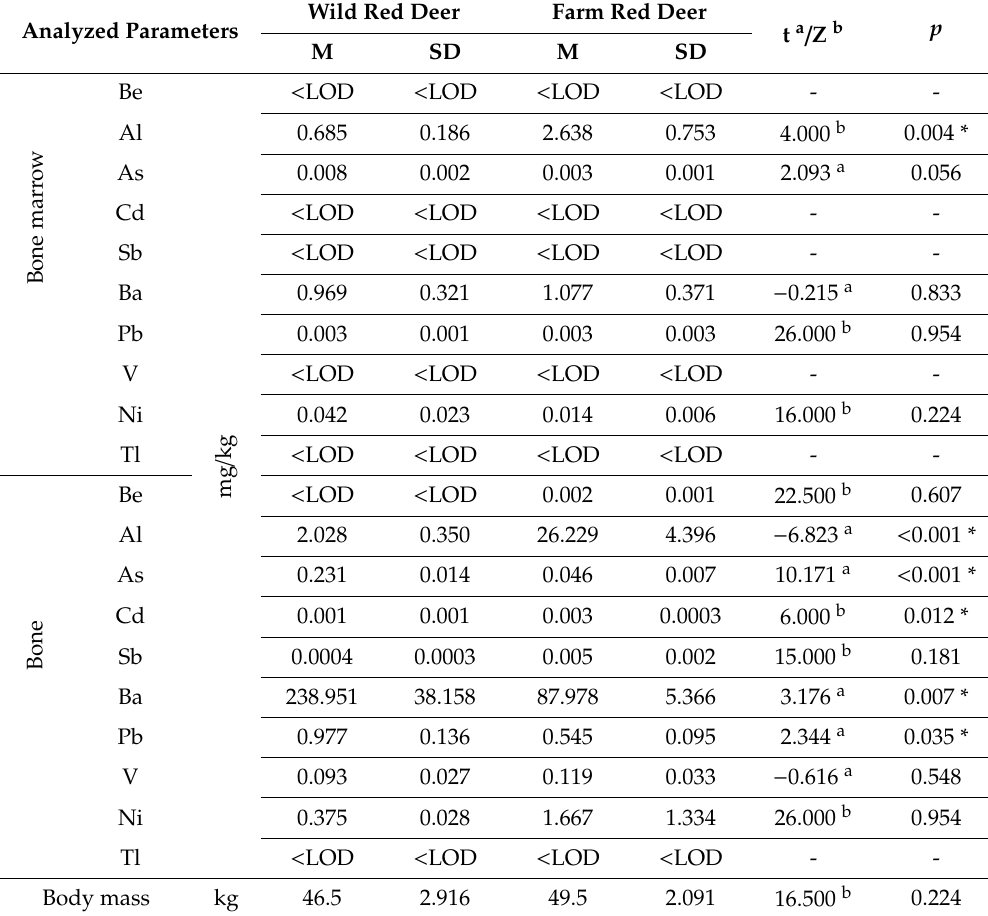
Table 1. Comparison of the Toxic elements (TE) concentrations in the bones and bone marrow between the wild and farmed red deer.